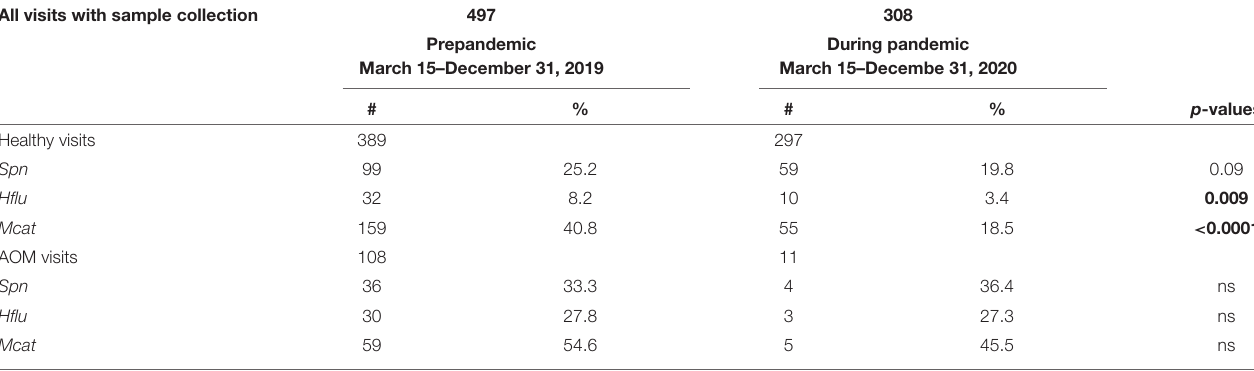
TABLE 2 | Comparison of the three main otopathogens in children before and during the pandemic, isolated during healthy and AOM visits, tabulated separately. All visits with sample collection 497